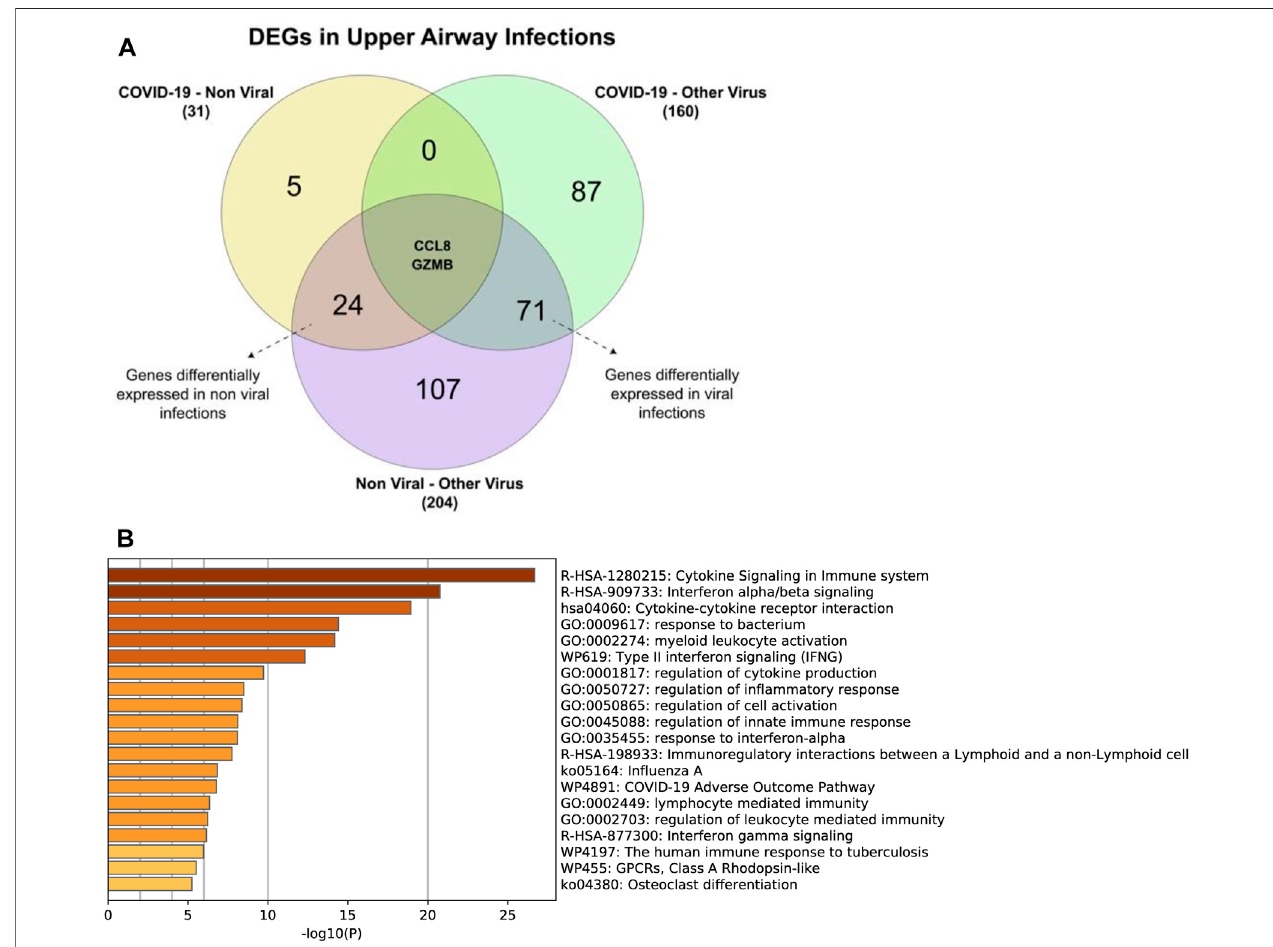
FIGURE 7 | (A) Number of genes differentially expressed genes between the different types of upper airway infections. And the enriched terms for genes that are differentially expressed in (B) all types of respiratory diseases.